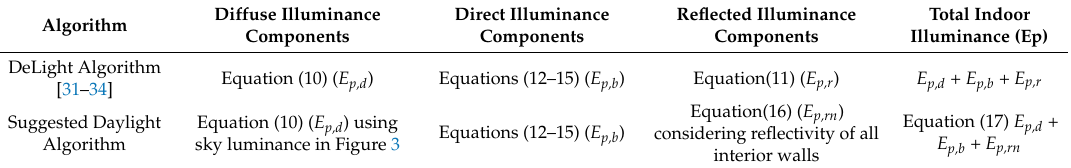
Figure 5. Diagram used in calculating the indoor illuminance in CIE clear and overcast sky.